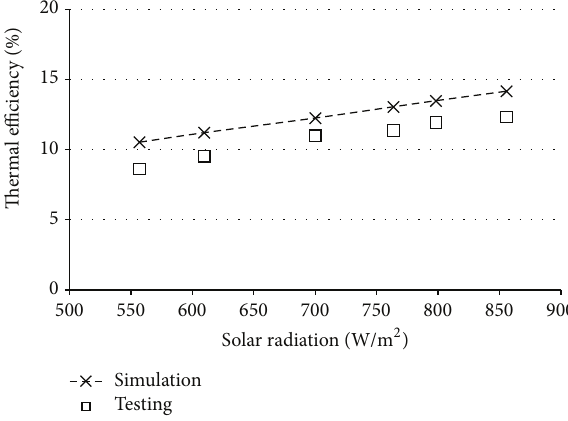
Figure 8: Variation of thermal efficiency with solar radiation.